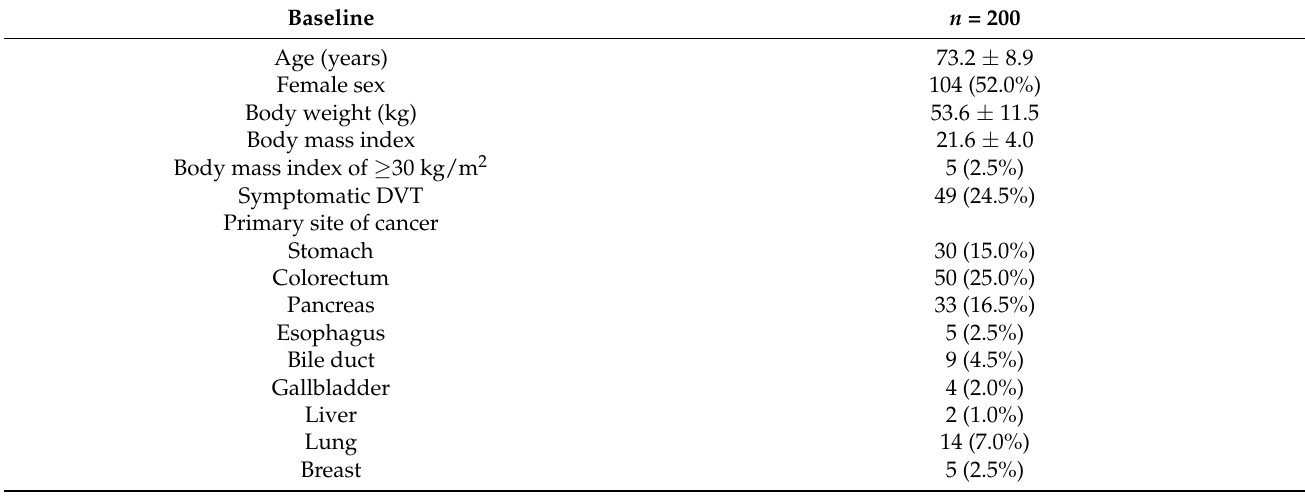
Table 1. Baseline